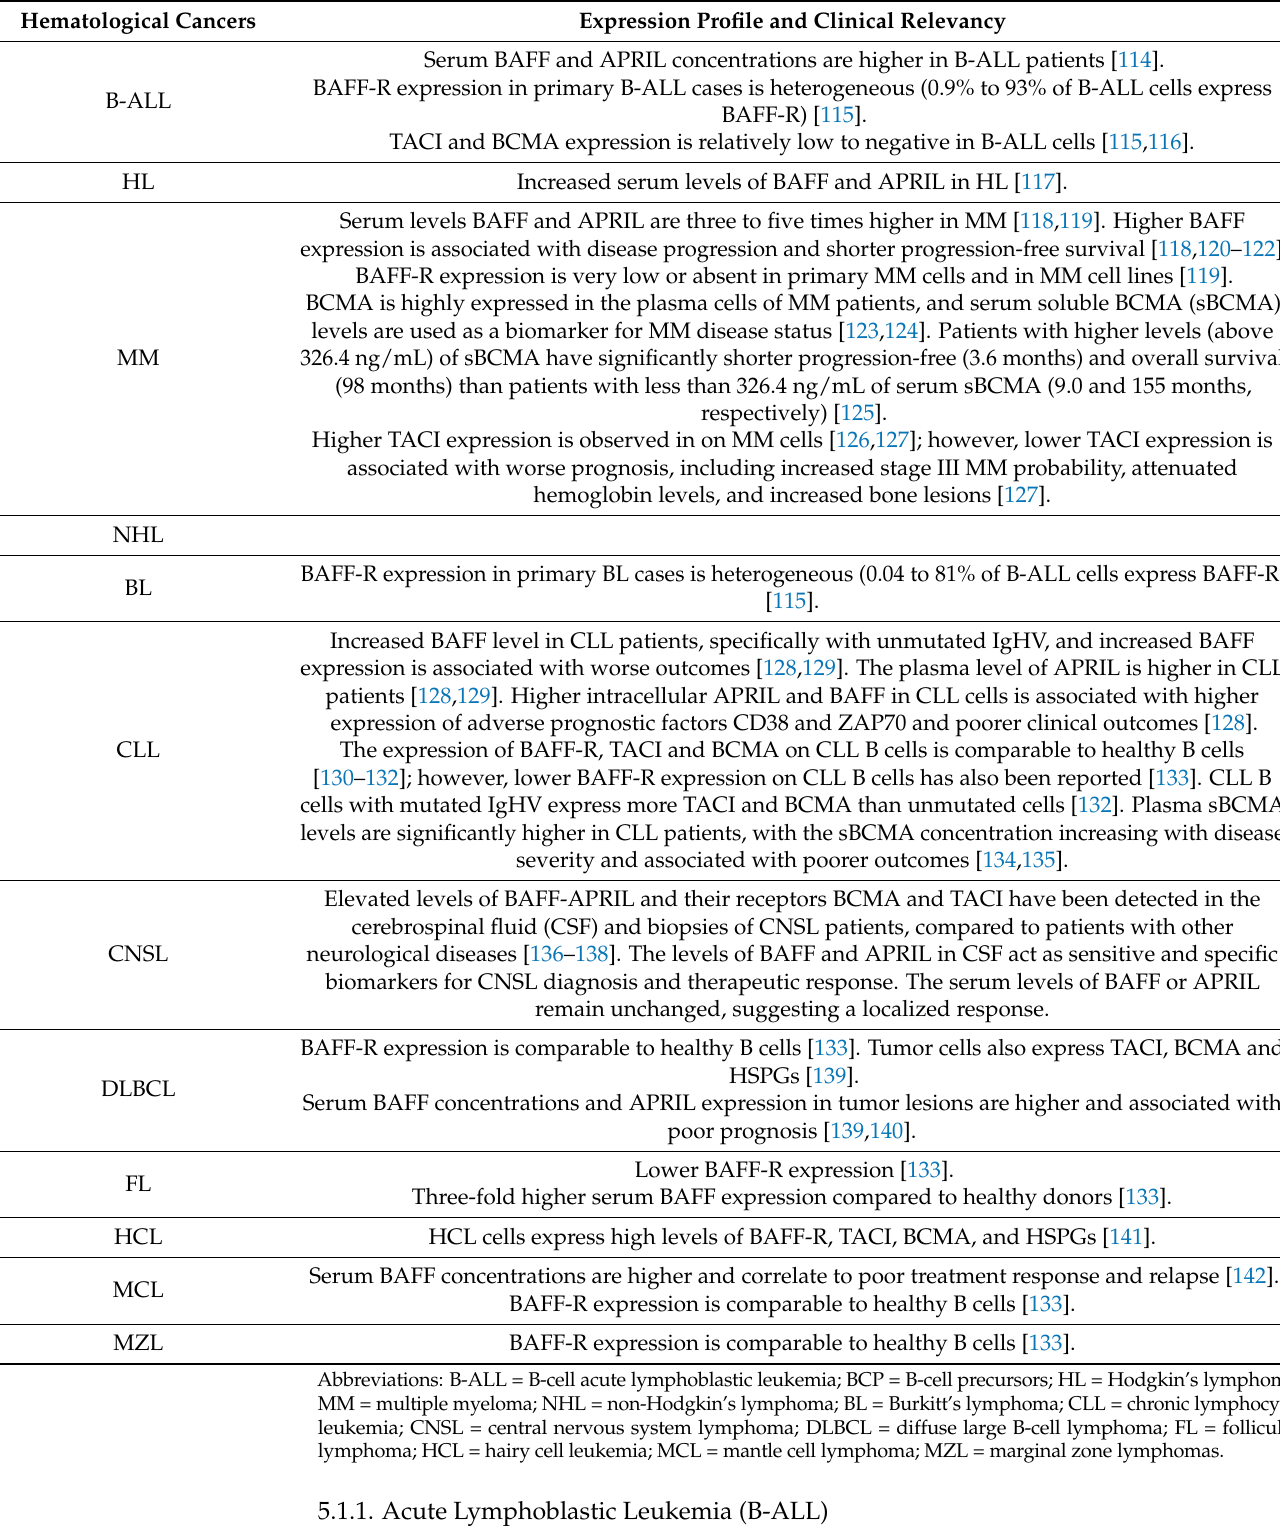
Table 1. Expression profile of the BAFF and APRIL system and clinical relevance in hematological